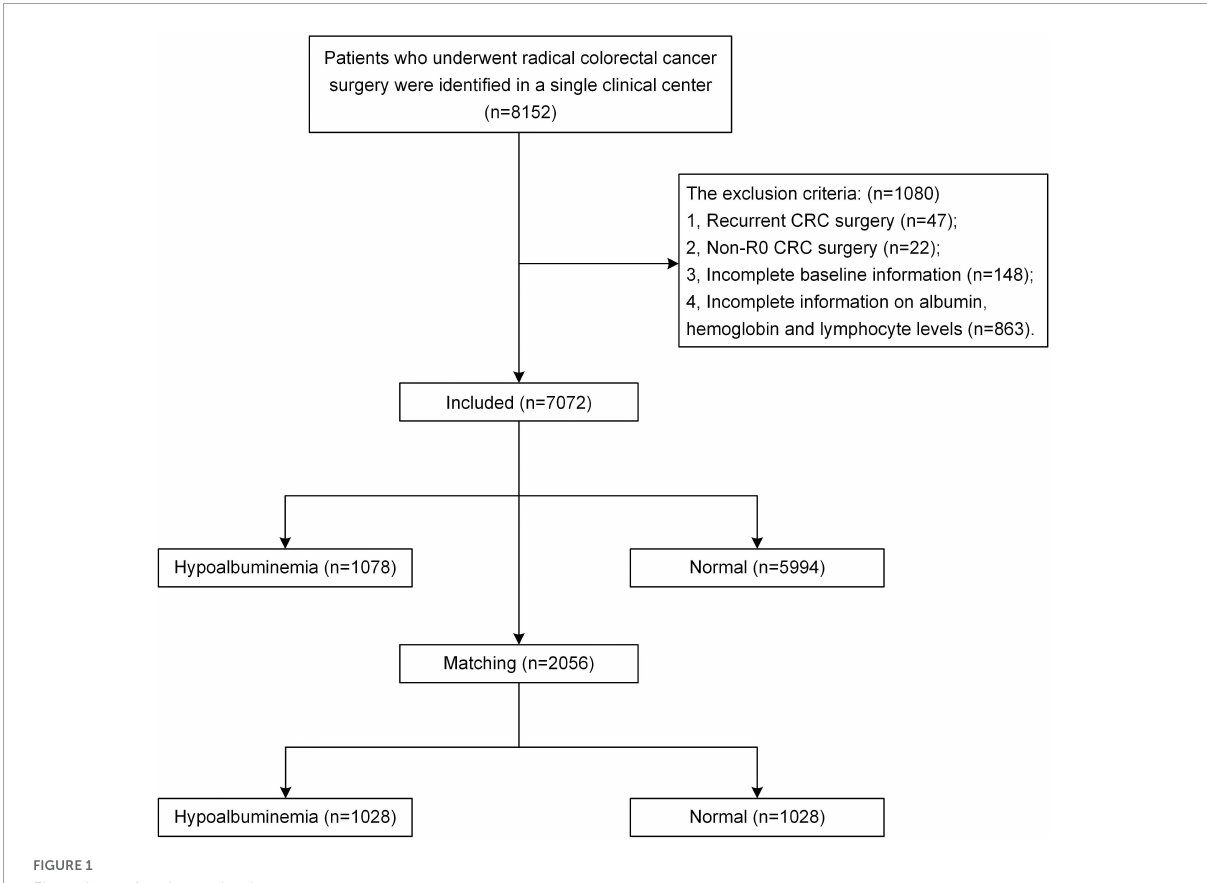
FIGURE1 Flow chart of patient